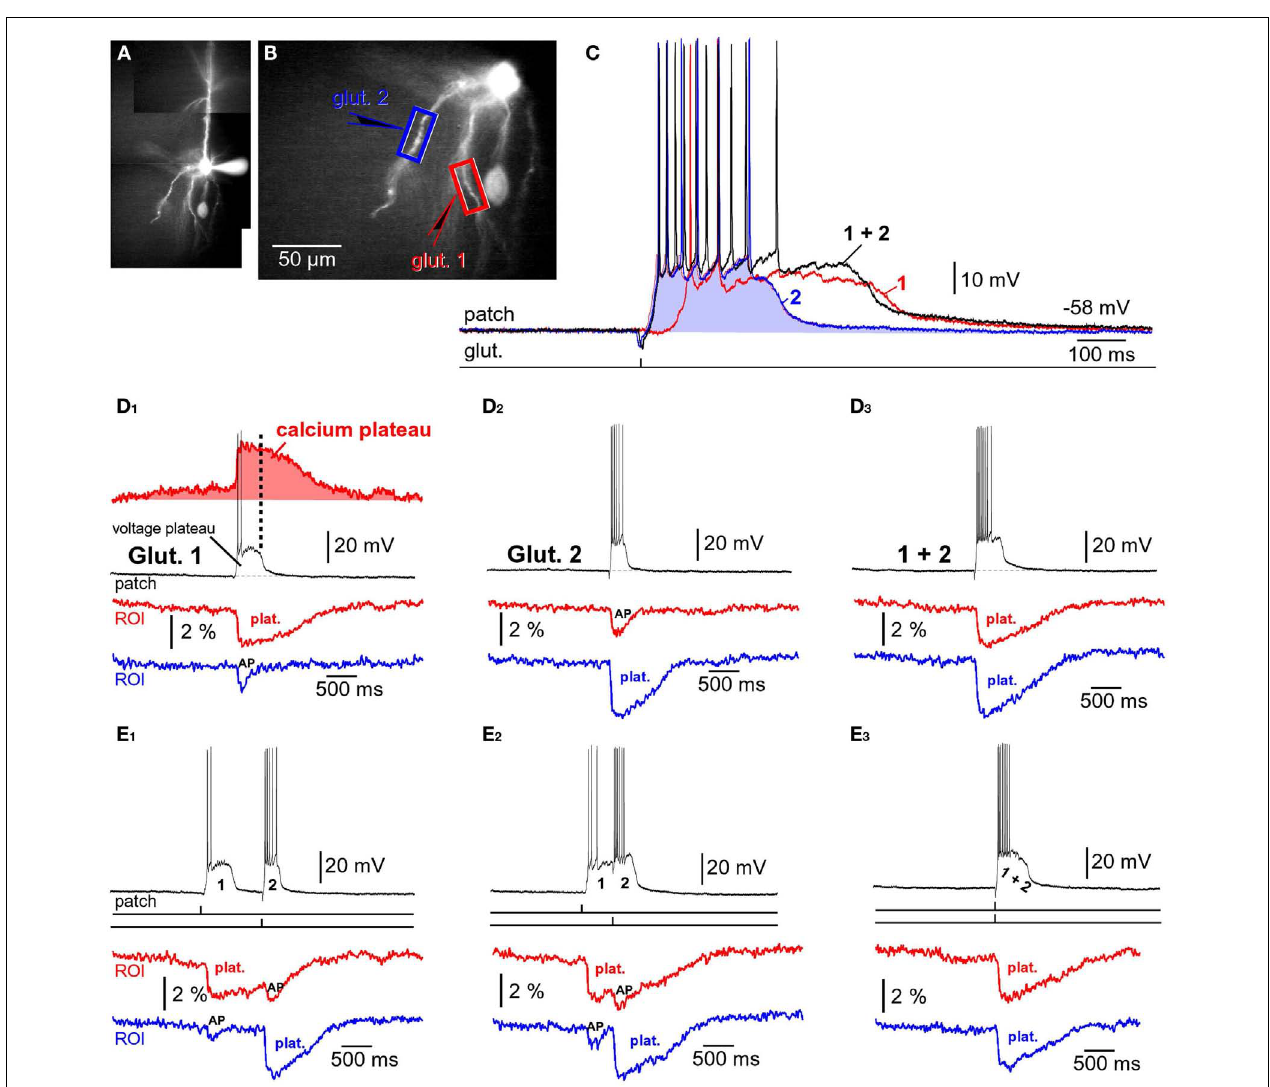
from the red ROI was inverted, arbitrarily scaled, and the area underneath the trace shaded red.Vertical dashed line marks the end of the neuronal plateau depolarization. (D 2 ) Same as in (D 1 ) , except glutamate pulse was applied at location glut. 2. (D 3 ) Same as in (D 1 ) , except two pulses (1 and 2) were co-applied at the same moment. (E 1 ) Ca 2 + transients (ROIs) and somatic membrane potential (patch) during glutamate iontophoresis on two basal dendrites. Precise timings of glut. 1 and glut. 2 pulses are marked by vertical ticks beneath the patch recording.Time interval between glut. 1 and glut. 2 was 1000ms. (E 2 ) Same as in (E 1 ) , except time interval between 1 and 2 was 500ms. (E 3 ) Same as in (E 1 ) , except 1 and 2 were applied simultaneously (interval =